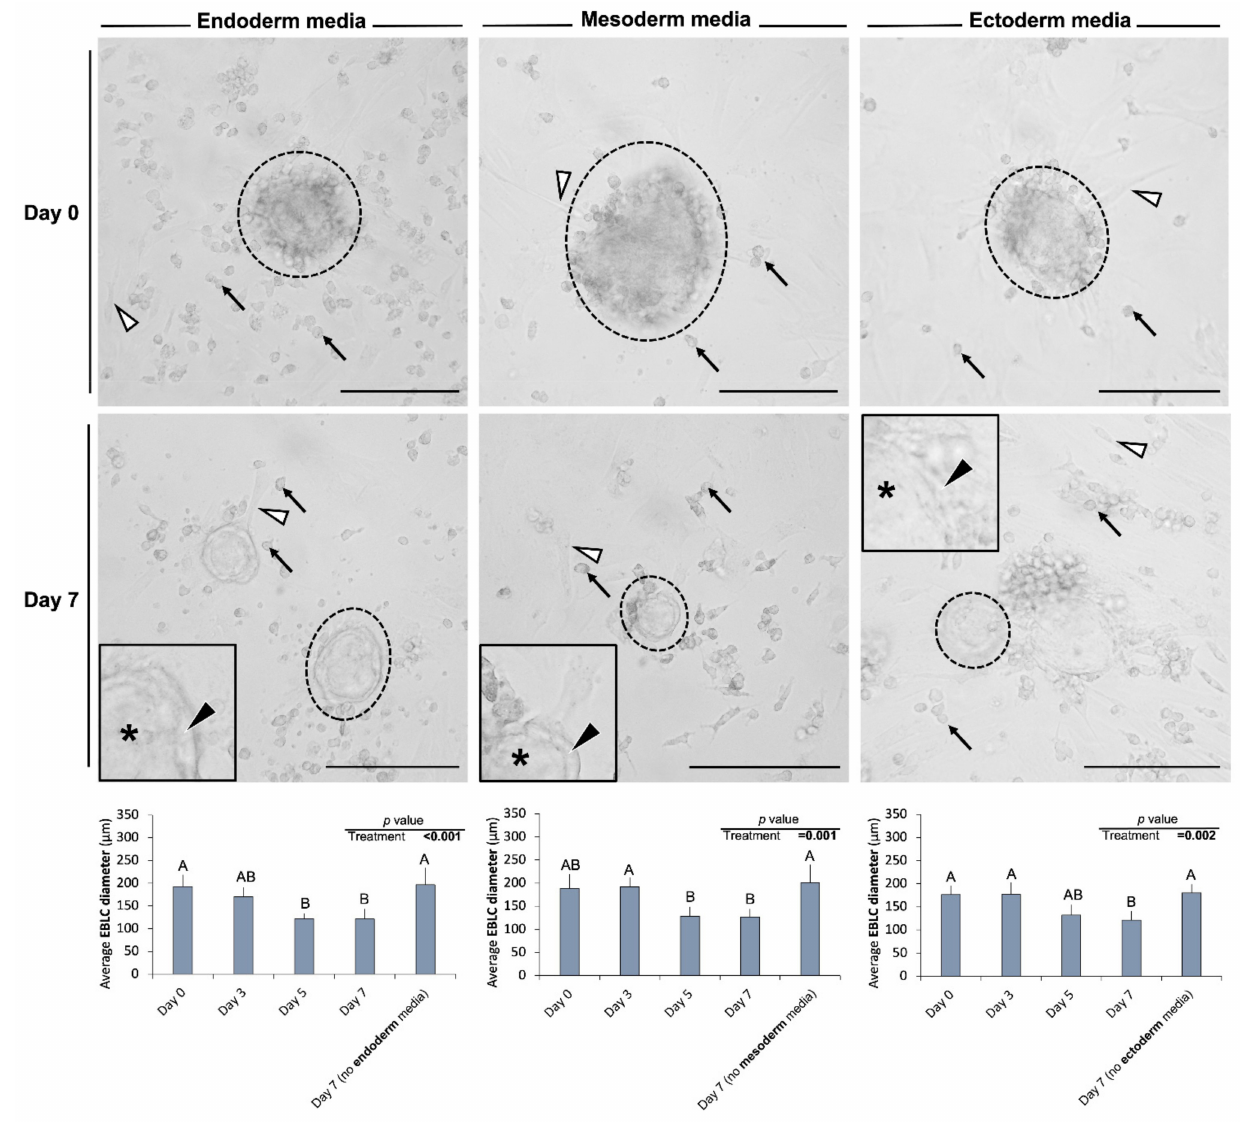
Figure 3. Representative photomicrographs obtained from culture wells before (day 0) and 7 days after incubation with the tri-lineage differentiation media. The overall morphological features of gonocytes (black arrows), embryoid body-like colonies (EBLCs) (dotted circles), and somatic cell monolayer (white arrowheads) did not differ between control groups provided with regular media (DMEM + 15% FBS + 10 ng/mL bFGF) and treatment groups incubated with ectoderm, mesoderm, or endoderm differentiation media. However, the diameter of EBLCs decreased in the three-differentiation media compared with those in the control group (0.001 < p ≤ 0.002). Also, the EBLCs in differentiation media possessed a narrow marginal area close to the periphery (black arrowheads) and more central areas (*). Insets show higher magnification. (Scale bar = 150 µ m). “A” and “B” denote significant differences and p < 0.05 was considered as the significance